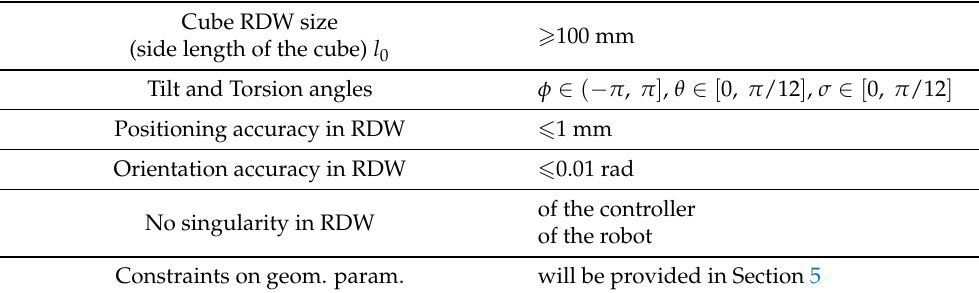
Table 1. Requirements of the Gough–Stewart